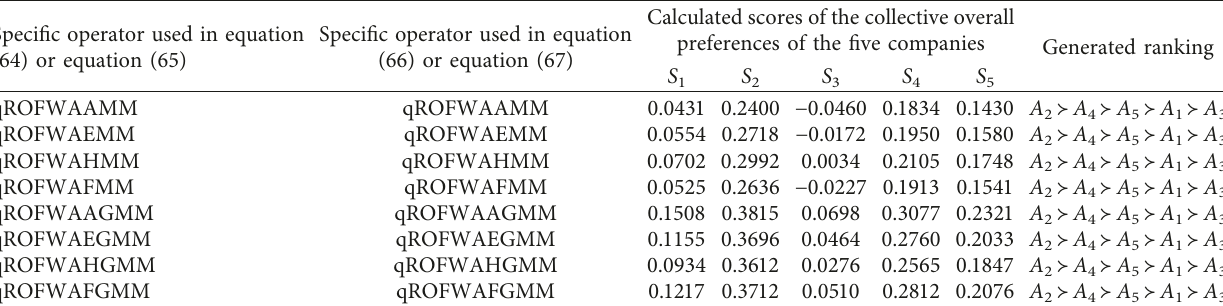
Table 1: The results of Experiment 1. Calculated scores of the collective overall Specific operator used in equation preferences of the five companies Generated (66) or equation (67)